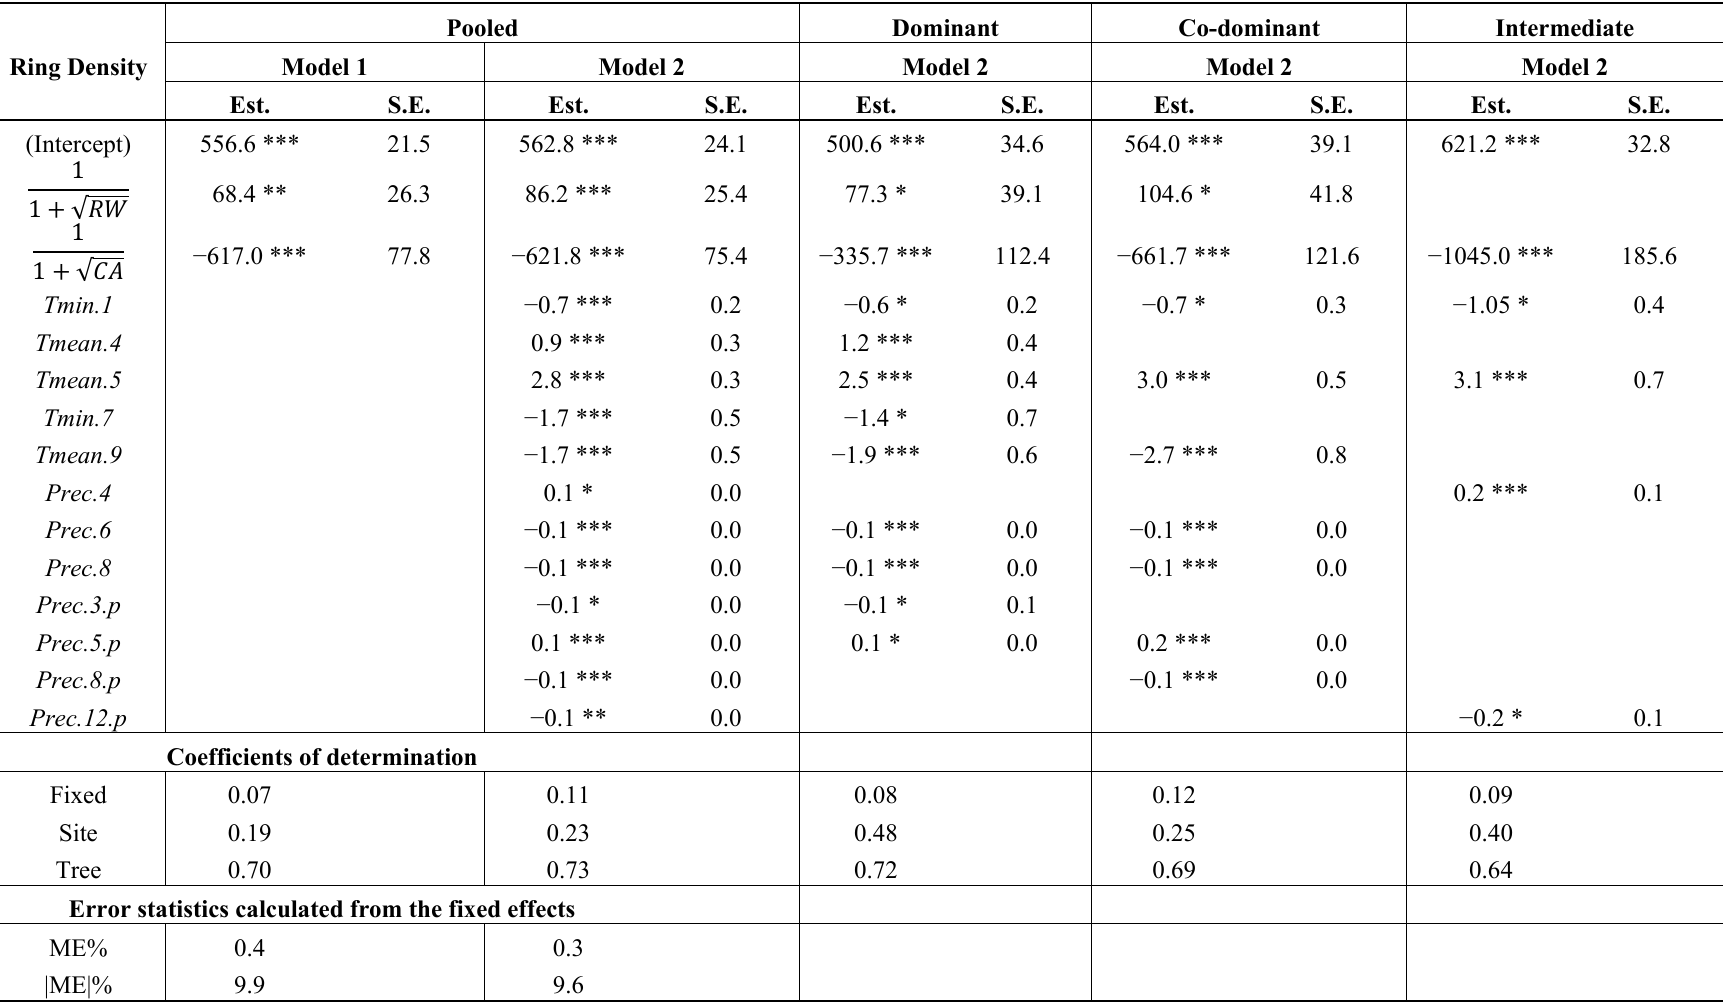
Table 5. Estimated coefficients (Est.) and associated standard error (S.E.) for ring density at different dominance